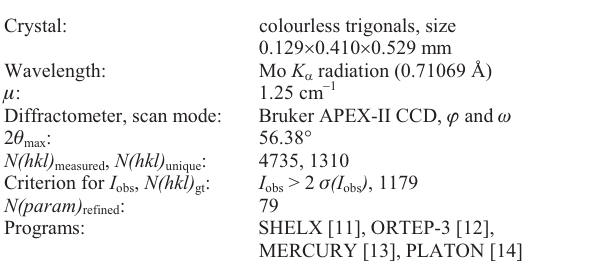
Table 1. Data collection and